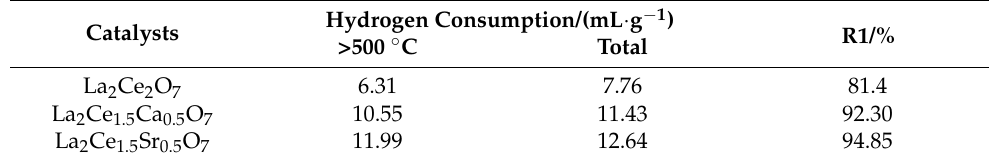
Figure 13. ( a ) XRD patterns of the indicated catalysts, ( b ) enlarge images of the main reflection in figure-a. Table 6. H 2 -TPR results of the